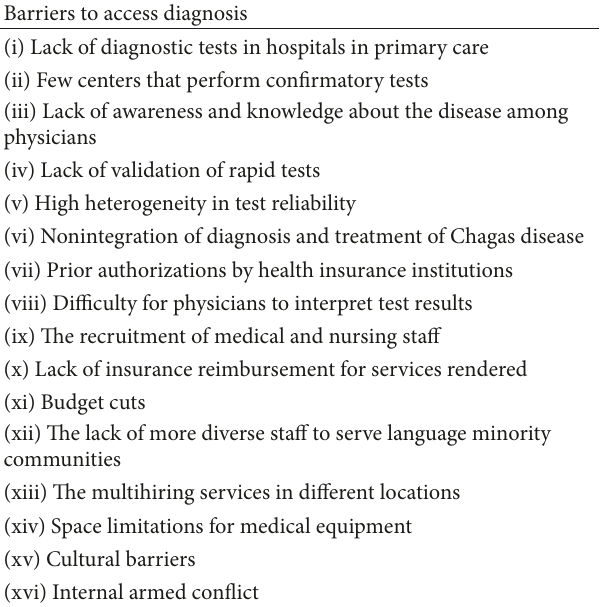
Table 2: Summary of barriers to diagnosis access for Chagas disease in Colombia.